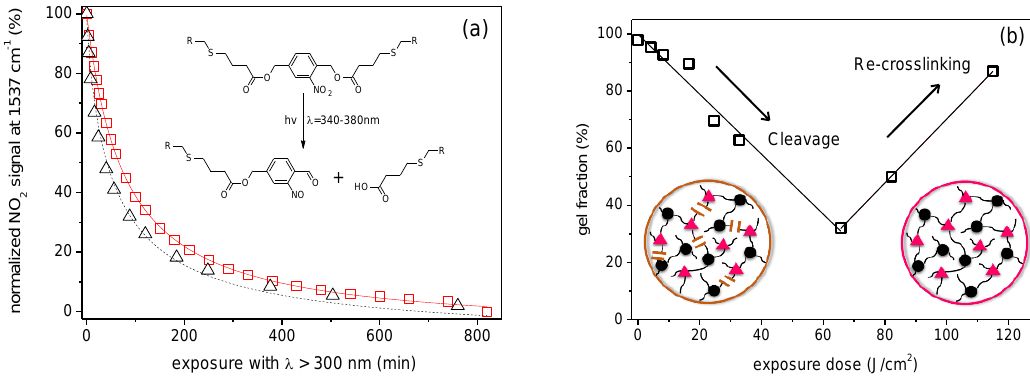
Figure 13. ( a ) Typical ortho-nitrobenzyl cleavage kinetic in thiol-click network. ( b ) Thiol-ene network’s normalized gel fraction after o-NBE photo-cleavage (Adapted from reference [117] published by the Royal Society of Chemistry).